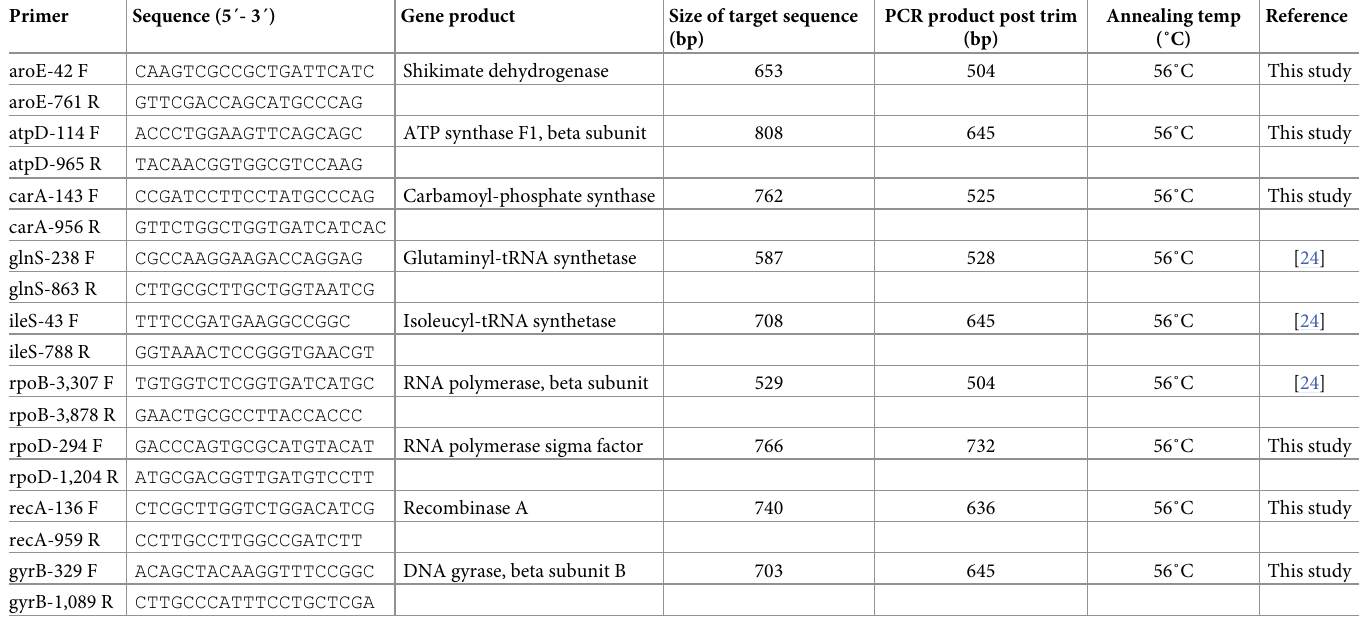
Table 3. Primers (without M13) for each of the nine housekeeping genes included in the